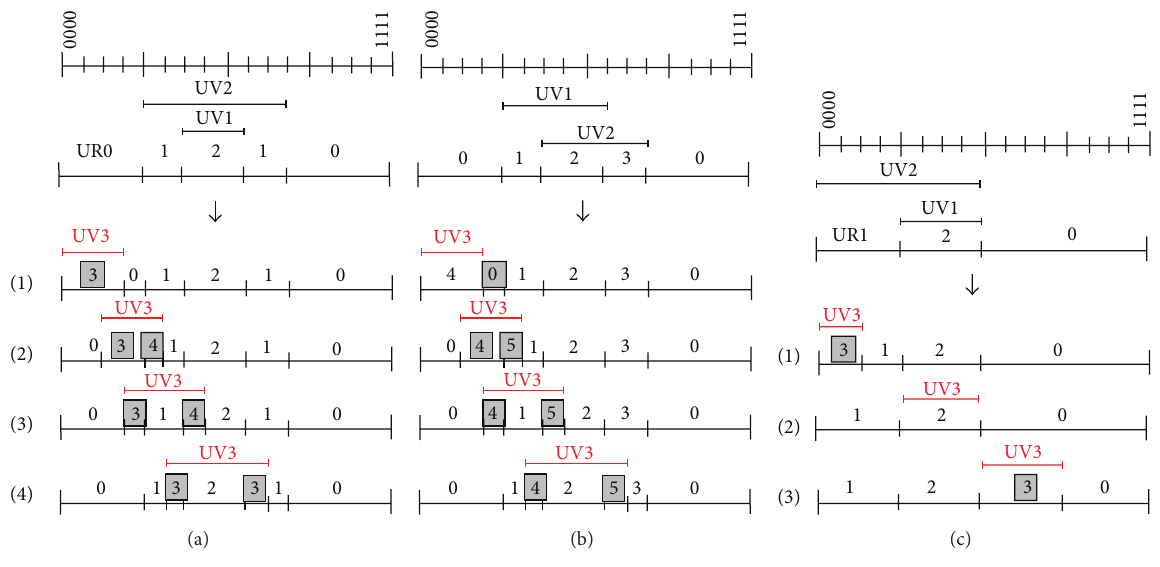
Figure 6: Effect of adding a new UV: (a) and (b) arbitrary range cases and (c) prefix